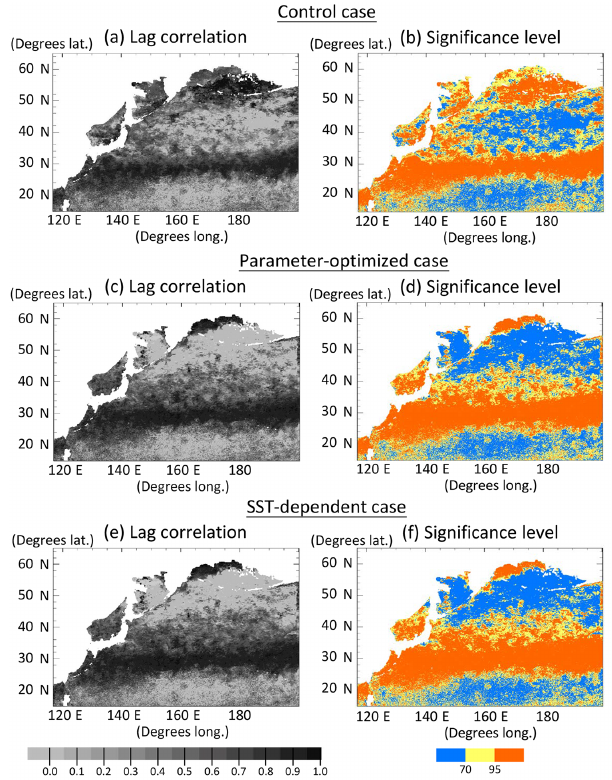
Figure 5. Horizontal distribution of lagged (within ± 2 months) cor- relation coefficients for the monthly time series of phytoplankton (PL + PS) concentration between the simulation and the satellite data in each grid at the surface in 1998, and the significance levels. (a, b) Control case, (c, d) parameter-optimized case, and (e, f) SST- dependent case. Areas with less than the number of seven monthly mean satellite data and in the coastal regions where the bottoms are less than 200m are left